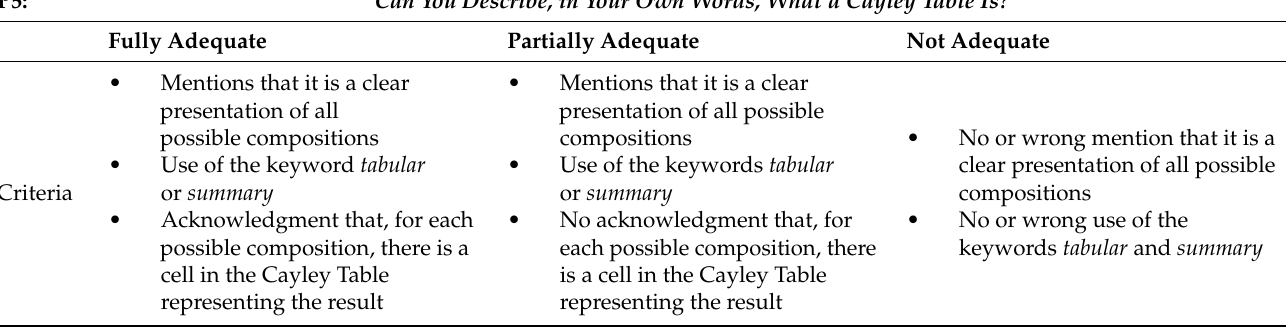
Table A13. Coding manual for the paraphrasing of key idea 5.